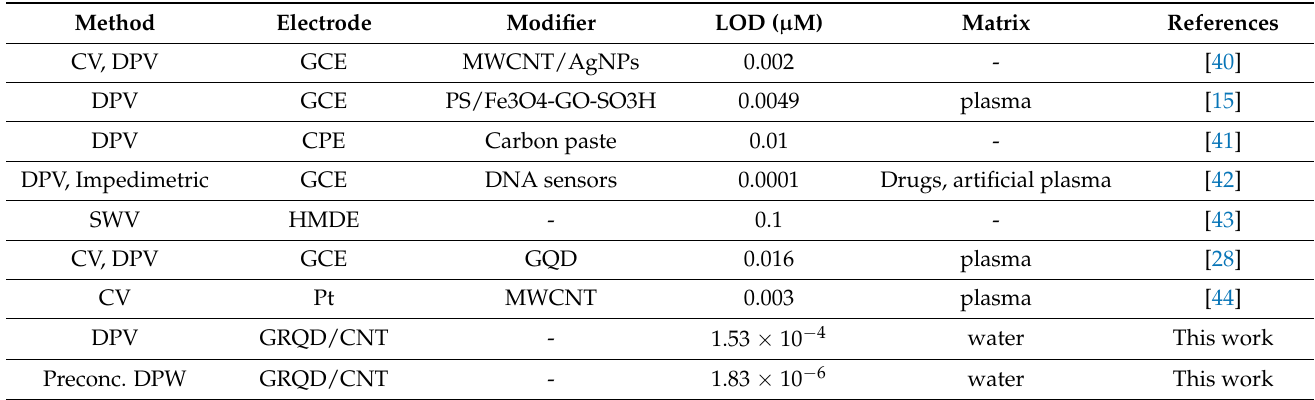
Table 4. Comparison of performances of GRQD/CNT paste electrode with carbon-based electrodes for electrochemical sensing of